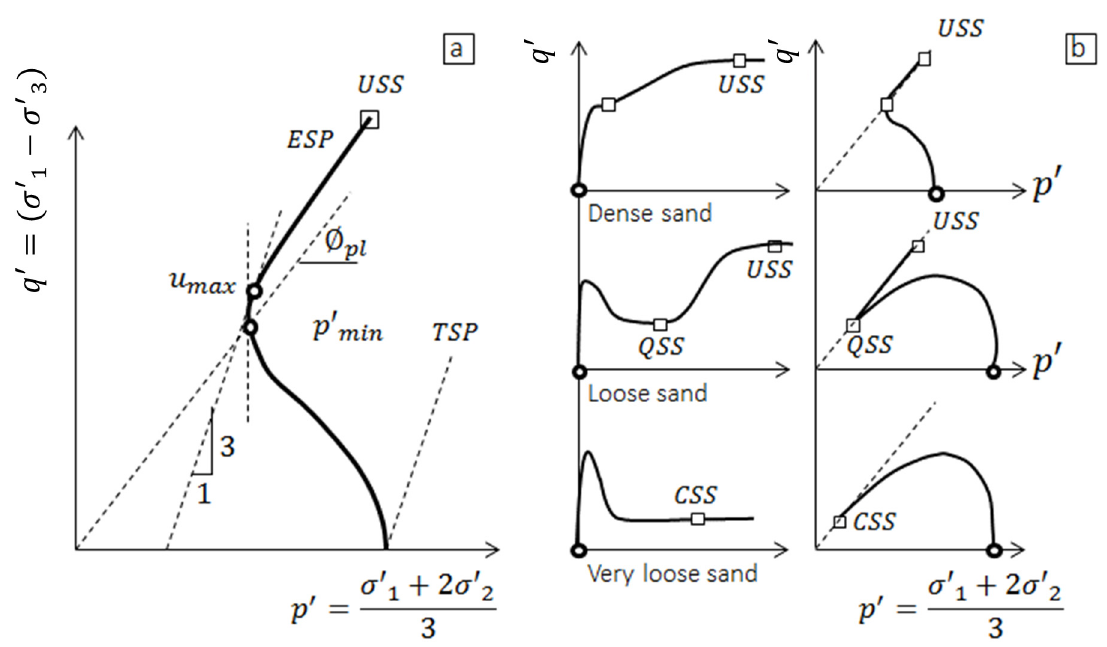
Figure 5. State transitions during undrained shearing of isotopically-consolidated triaxial specimens: ( a ) phase transformation state; ( b ) steady states ([35] with modifications).